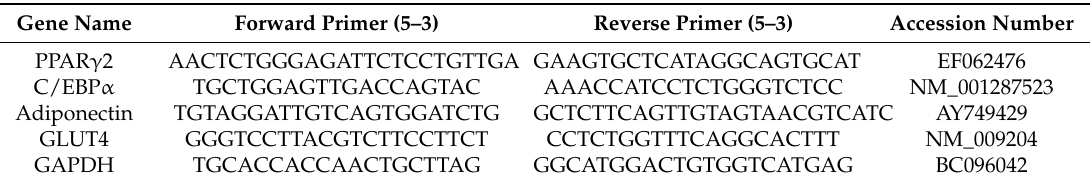
Table 1. Oligonucleotide primer sequences used for the qRT-PCR